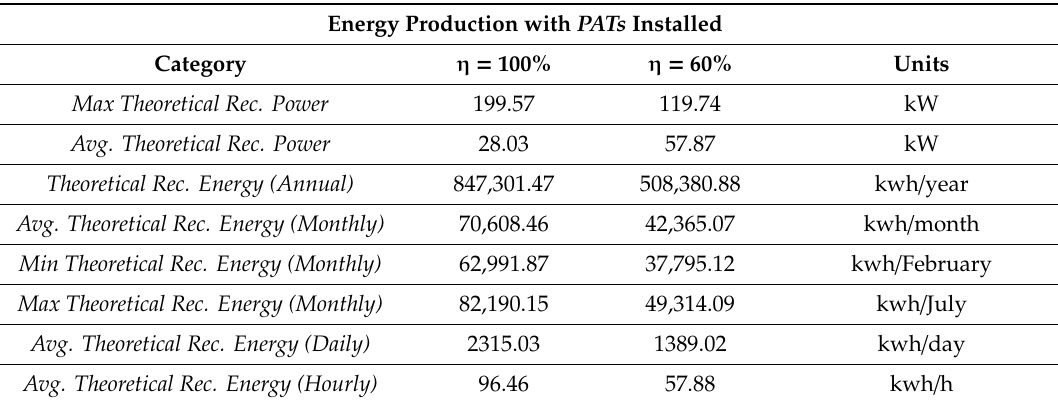
Table 8. Highlights from energy balance at point #7 for each scenario.